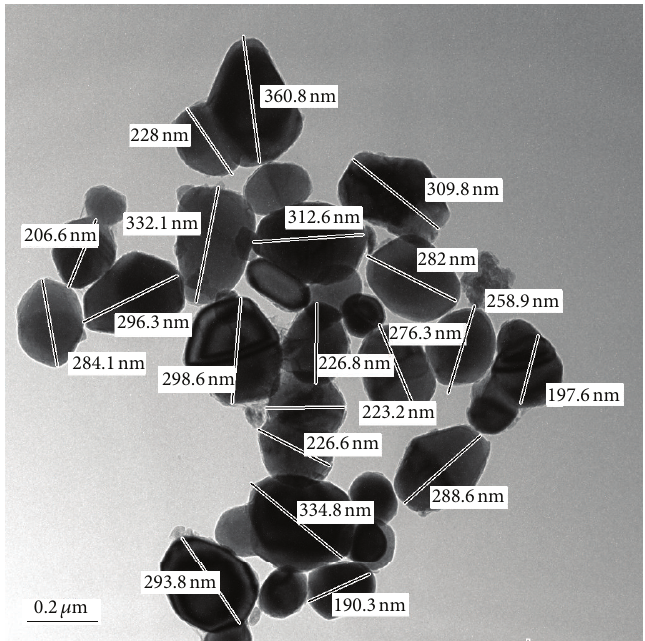
Figure 4: TEM image of the TiO 2 nanoparticle aggregates.